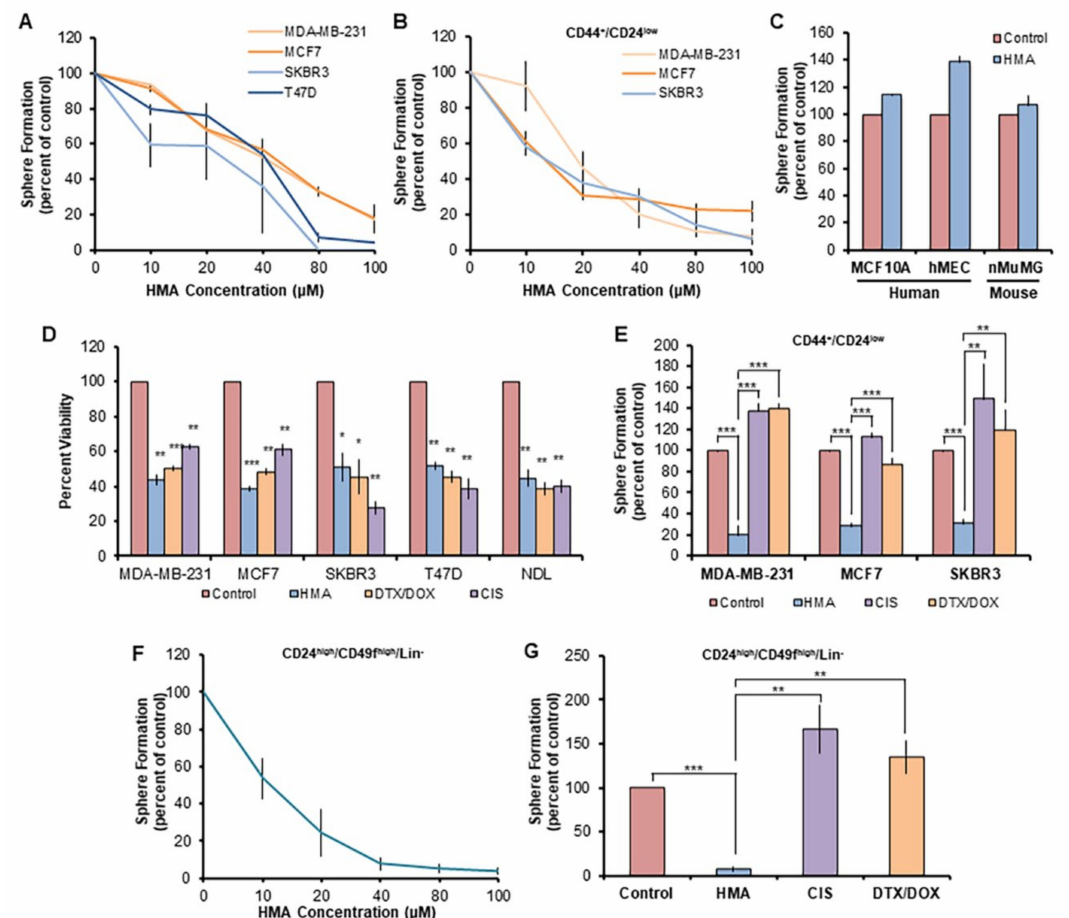
Figure 1. HMA ablates chemotherapy-resistant BCSCs but not normal mammary stem-like cells. ( A ) Secondary tumorsphere formation by human breast cancer cell lines was assessed after pretreat- ment with various concentrations of HMA for 24 h. Data are representative of three independent experiments. ( B ) Secondary sphere formation by CD44 + /CD24 low BCSC-enriched human breast cancer cells after HMA pretreatment. ( C ) Secondary mammosphere formation of non-transformed human and mouse mammary epithelial cell lines was assessed after 40 µ M HMA treatment for 24 h. ( D ) Total populations of MDA-MB-231, MCF7, SKBR3, and T47D cells were treated with vehicle (DMSO), 40 µ M HMA, 40 µ M cisplatin (CIS), or a combination of 170 nM doxorubicin (DOX) and 50 nM docetaxel (DTX) for 24 h, and cell viability was determined by trypan blue exclusion assay. ( E ) Sorted human BCSC cells were treated with vehicle, 40 µ M HMA, 40 µ M CIS, or 170 nM DOX with 50 nM DTX, and secondary sphere formation was determined. ( F , G ) Cells dissociated from MMTV-NDL mouse mammary tumors were sorted (CD24 high /CD49f high /Lin − ) to enrich for the BCSC population, and 7-day sphere formation following pretreatment with HMA ( F ) or standard chemotherapeutics ( G ) was quantified over four biological tumor replicates from independent mice. Error bars represent SEM. *, p < 0.05; **, p < 0.01; ***, p < 0.001, by Student’s t